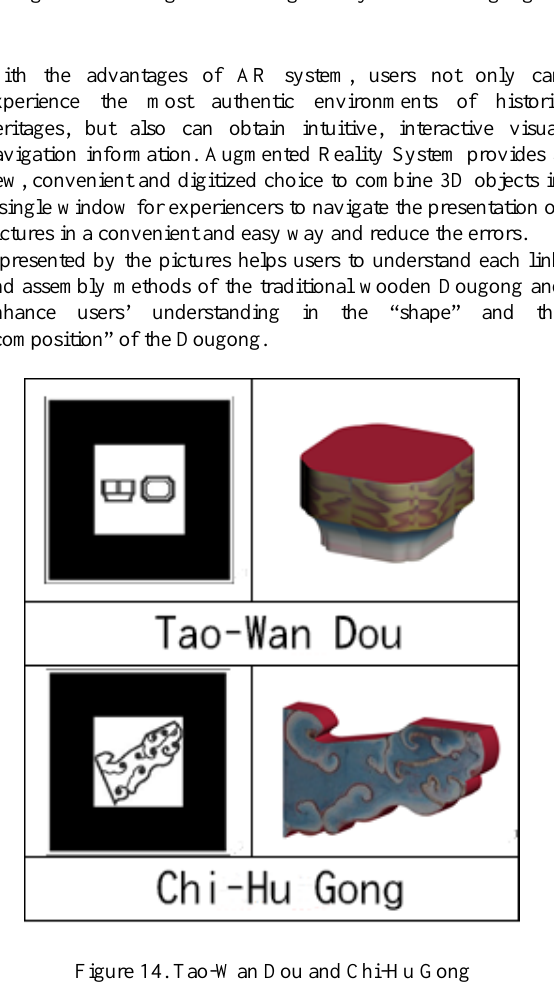
Figure 13. AR digitalized navigation system for Dougong